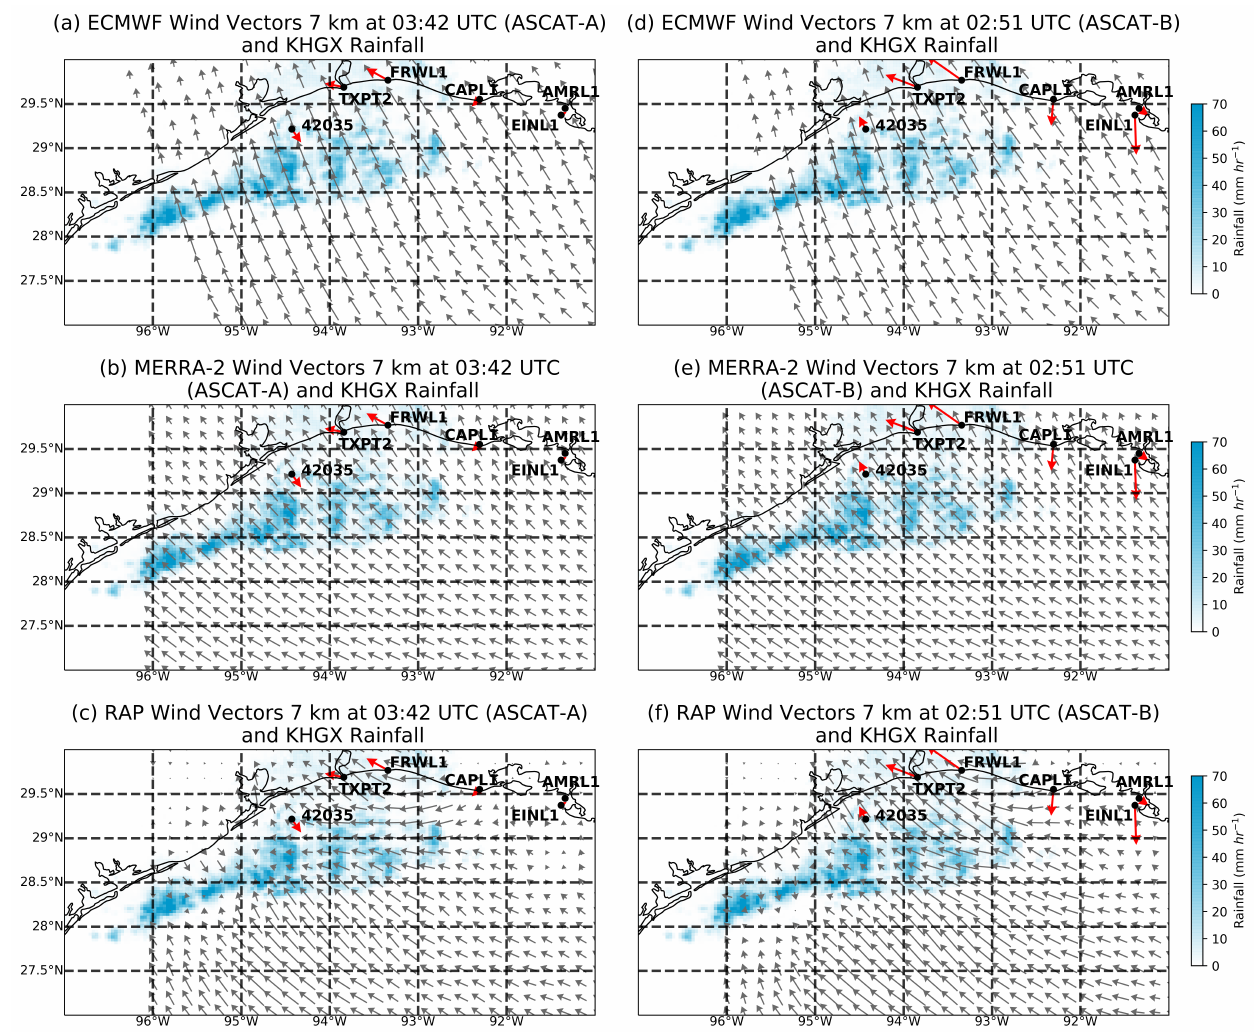
Figure 7. Background wind vectors are depicted in black for ( a ) ECMWF, ( b ) MERRA-2 and ( c ) RAP model at 02:51 UTC (ASCAT-A) on 28 May 2016; similarly for ( d , e , f ) but at 03:42 UTC (ASCAT-B). KHGX rainfall rate is depicted in light blue filled contours and reported at 02:57 UTC for ASCAT-A and 03:46 UTC for ASCAT-B. Buoy measurements at different stations are depicted in red